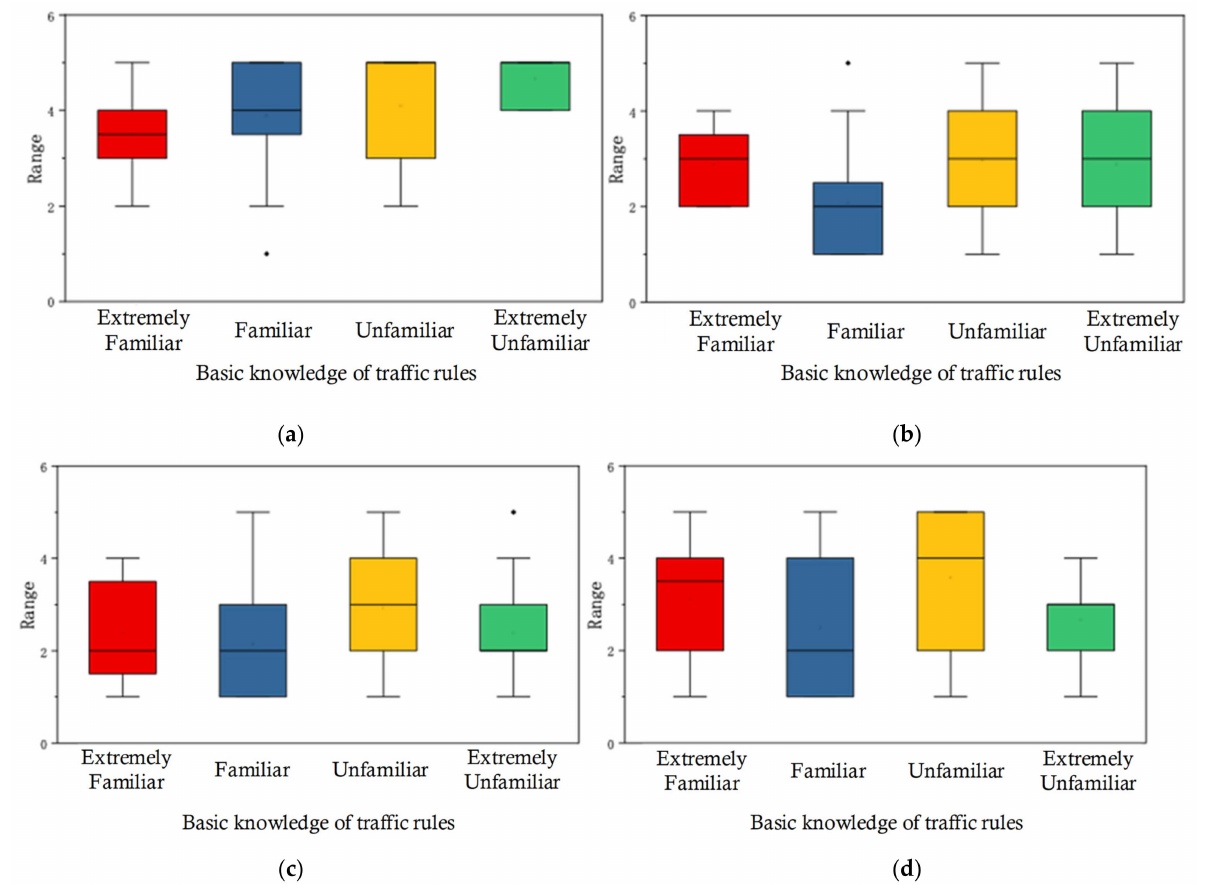
Figure 5. The rank distribution of eHMIs: ( a ) Textual eHMI, ( b ) Arrowed eHMI, ( c ) Tick and Cross eHMI, and ( d ) Traffic Lights eHMI in terms of basic knowledge of traffic rules, presented through boxplots.